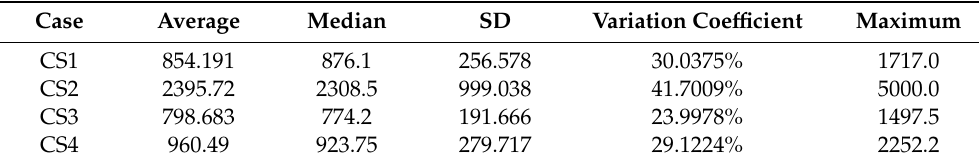
Table 8. CO 2 concentration (ppm) during lockdown.